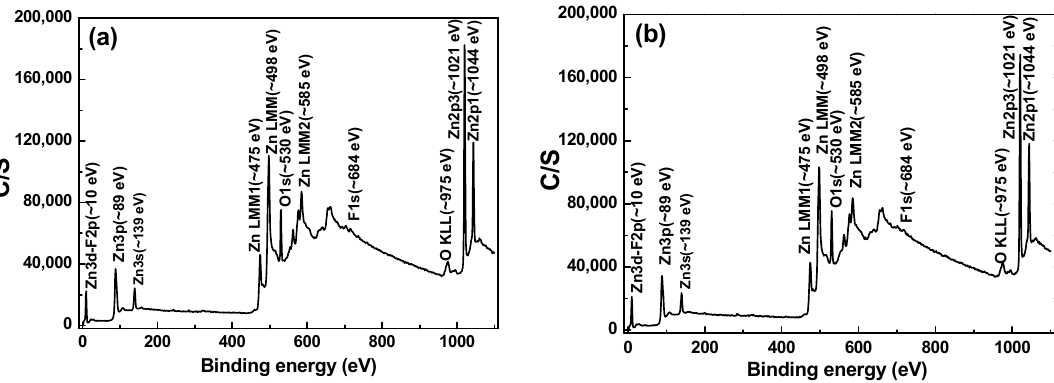
Figure 8. Full scanning X-ray photoelectron spectroscopy (XPS) spectra as a function of FZO films on different PI substrates: ( a ) Unmodified and ( b ) O 2 plasma pretreatment time of 30 s.